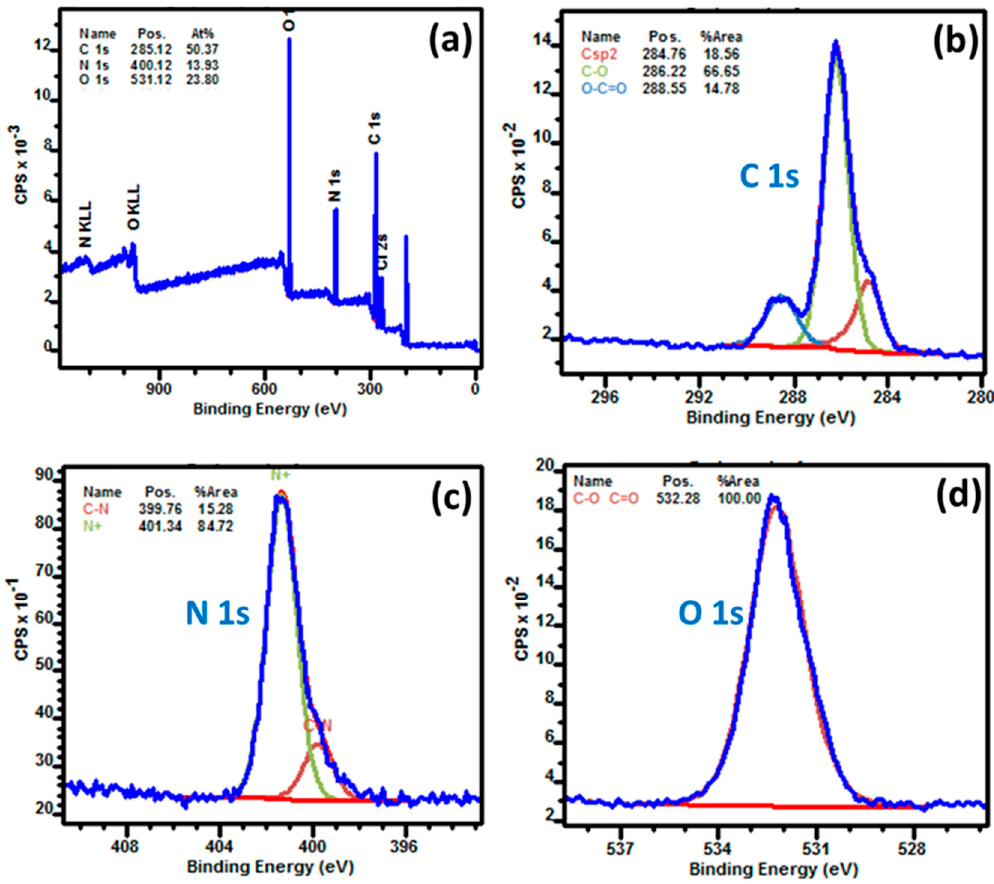
Figure 3. XPS data of GQDs ( a ) full-scan XPS spectrum, ( b ) C 1s spectrum, ( c ) N 1s spectrum, and ( d ) O 1s spectrum.